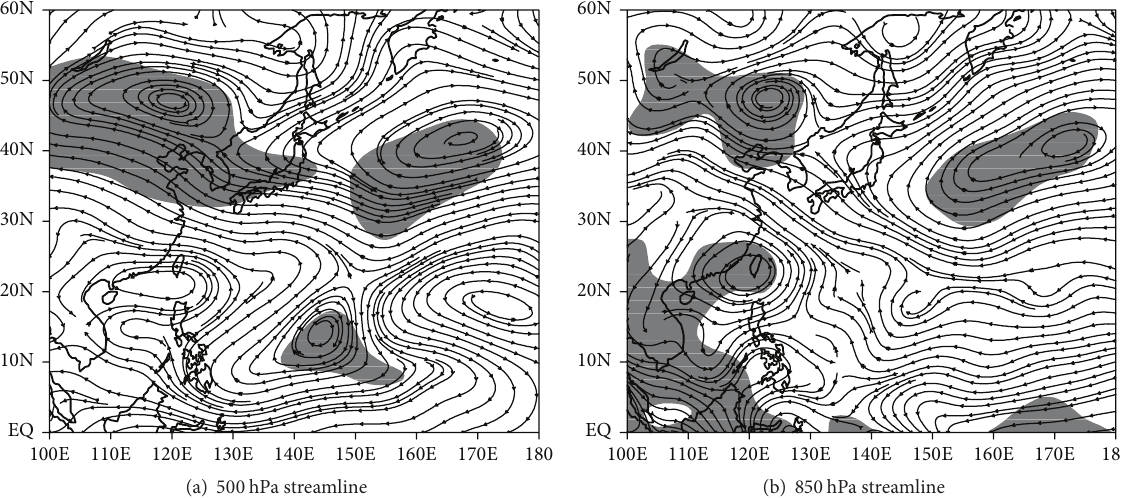
Figure 3: Differences in (a) 500 hPa and (b) 850 hPa streamline between the periods of 1999–2013 and 1977–1998. Shaded areas indicate that differences are significant at the 95% confidence level.